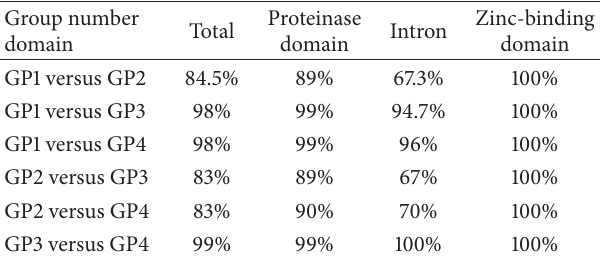
Table 5: DNA sequence homology for different structural domains of the four groups of C. s. scutulatus metalloproteinase